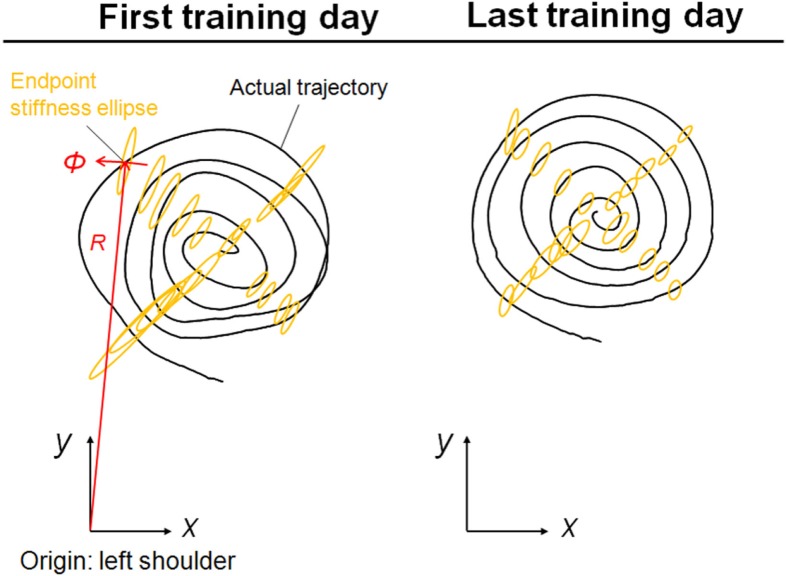
Typical change in endpoint stiffness from the first and last days of voluntary training (Subject #1). While its size changed, the shape and orientation of the endpoint-stiffness ellipse did not alter much during training. The orientation of the major axis of the ellipse tended to tilt toward the direction connecting the shoulder and the endpoint (i.e., the radial direction). This indicates that the endpoint stiffness in the tangential direction tends to be far smaller than that in the radial direction.